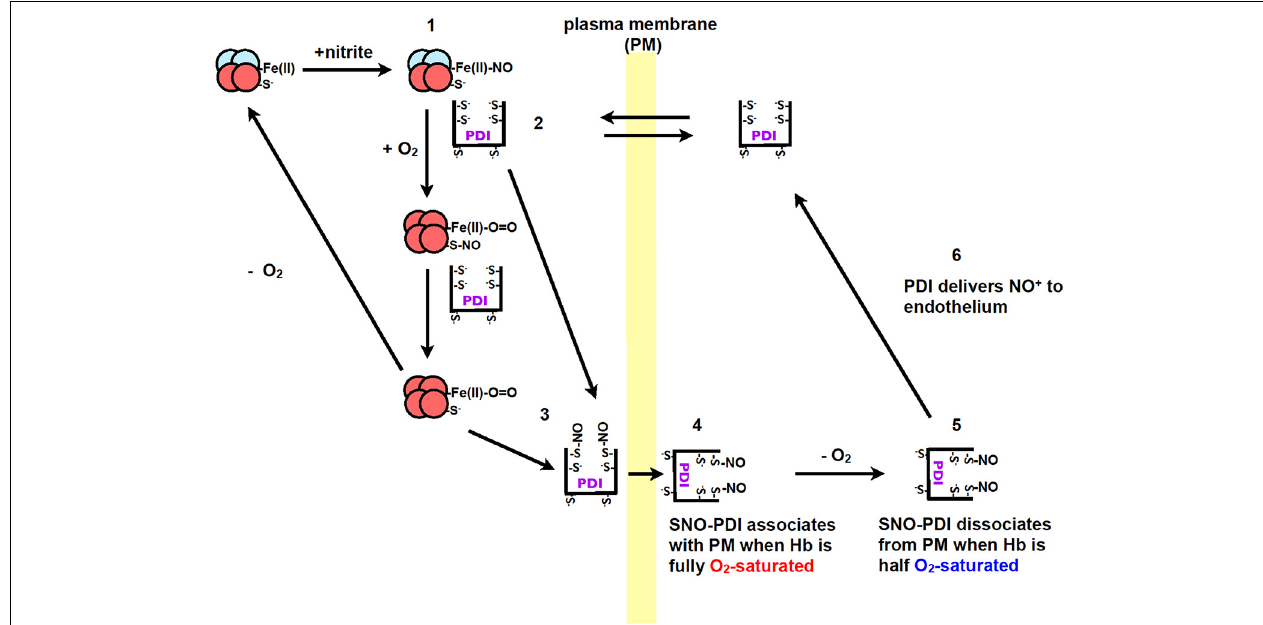
β 93), resulting in the formation of SNO-PDI. (4) PDI attaches to the extracellular surface of red blood cells under normoxic conditions. (5) When the red blood cells enter tissue that is under hypoxic conditions, SNO-PDI is released. (6) SNO-PDI interacts with the endothelium cells, releasing NO + /NO triggering hypoxic vasodilation. Image taken from Kallakunta et al.